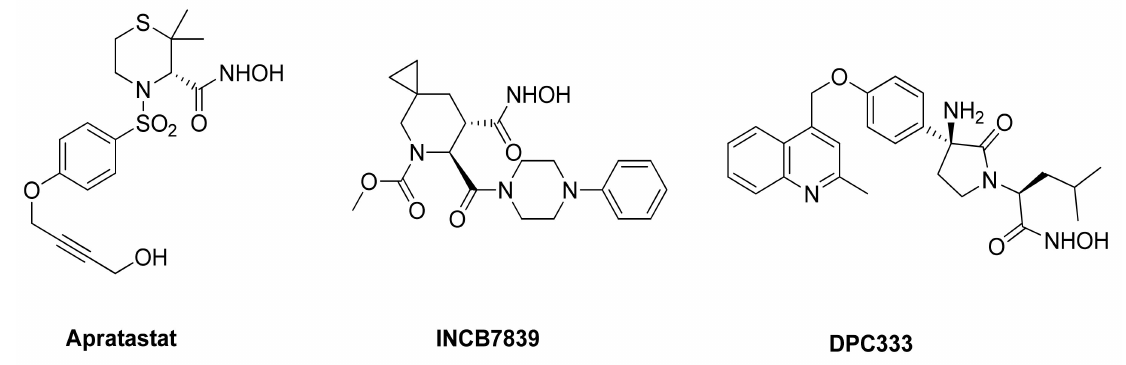
Figure 3. Chemical structure of ADAM17 inhibitors entered in clinical